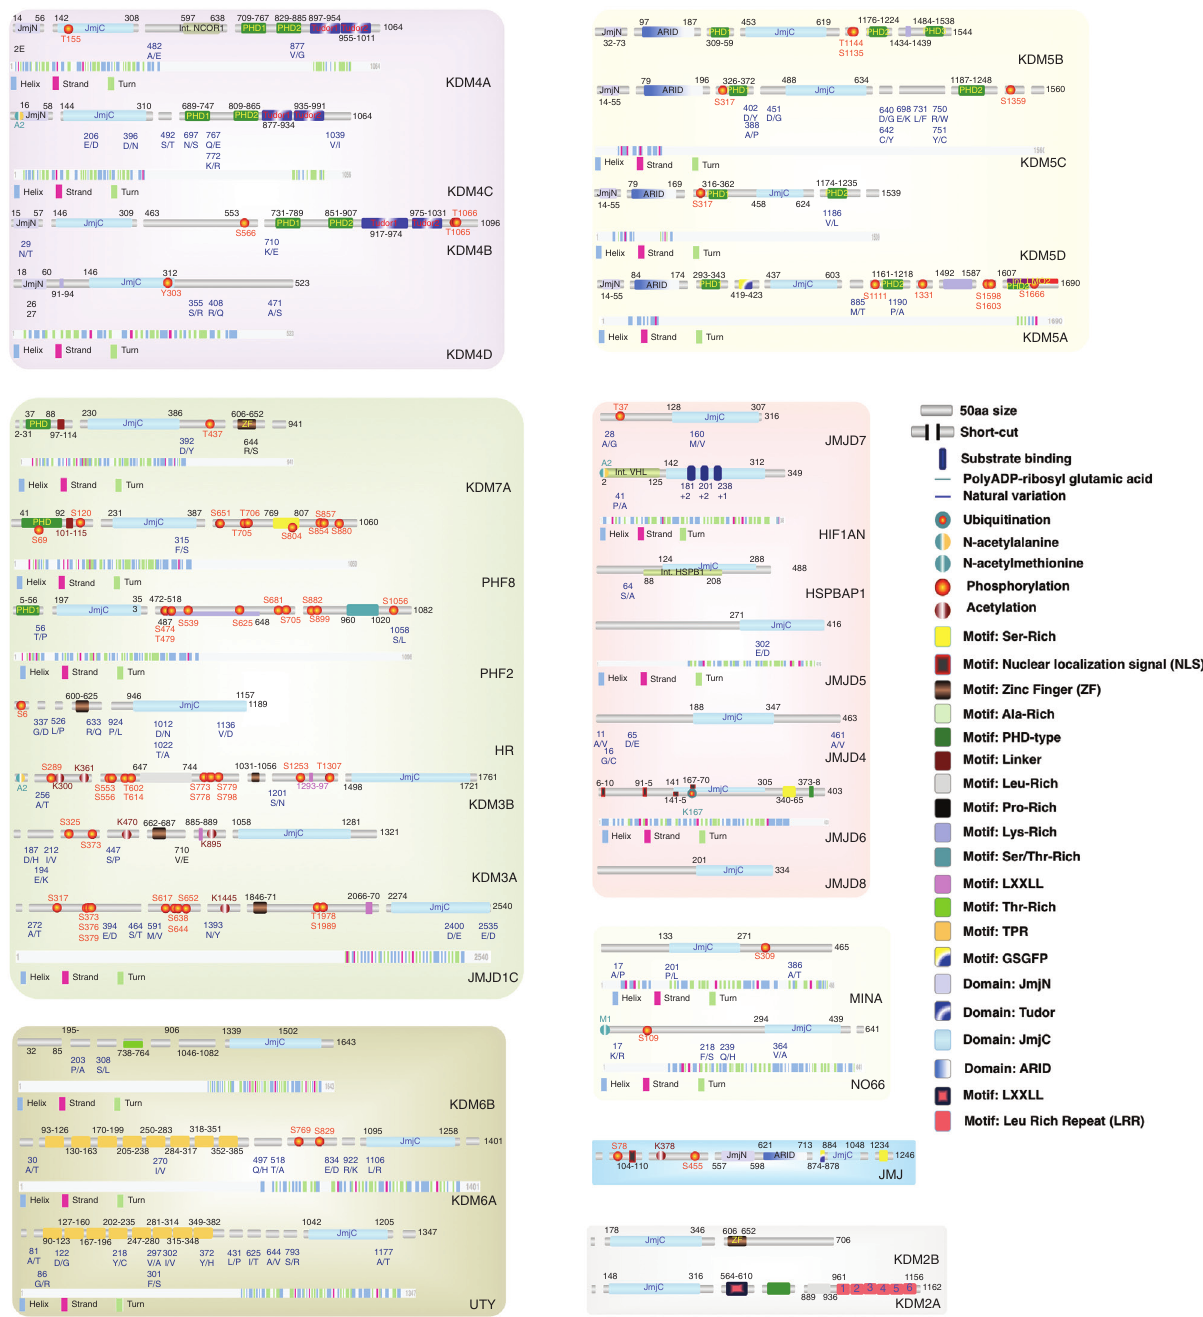
Figure 1 Schematic representation of JmjC family proteins based on UniProt database information showing structural domains, motifs, PTMs and secondary structures.